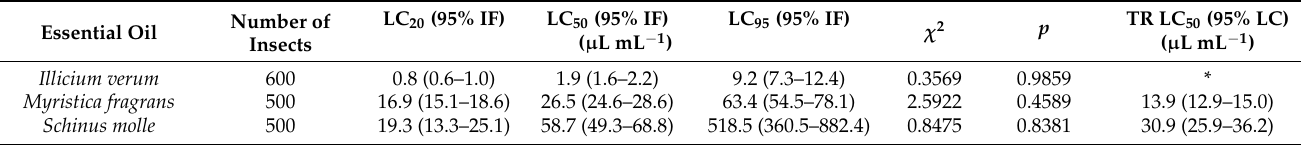
Table 2. Toxicological performance of essential oils on Drosophila suzukii .